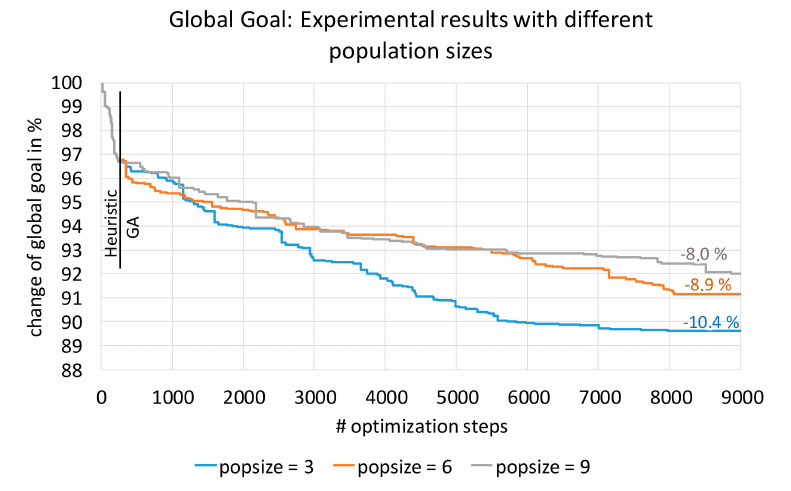
Figure 8. Results with di ff erent population